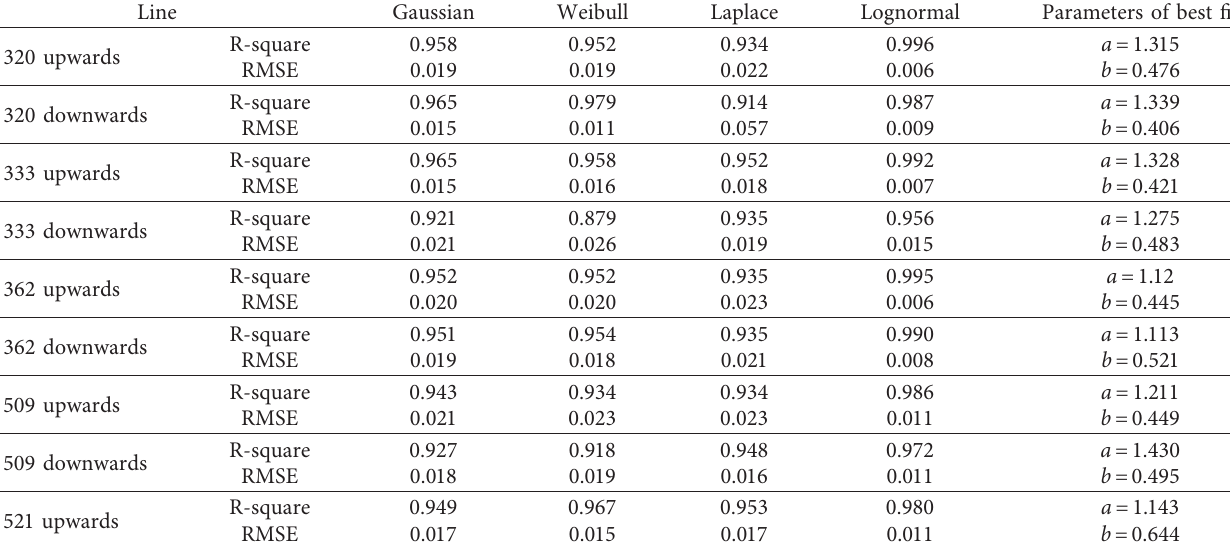
Figure 7: Spatial and temporal distribution of sample bus lines. (a) Microcirculation lines. (b) Conventional lines. Table 5: Fitting results of